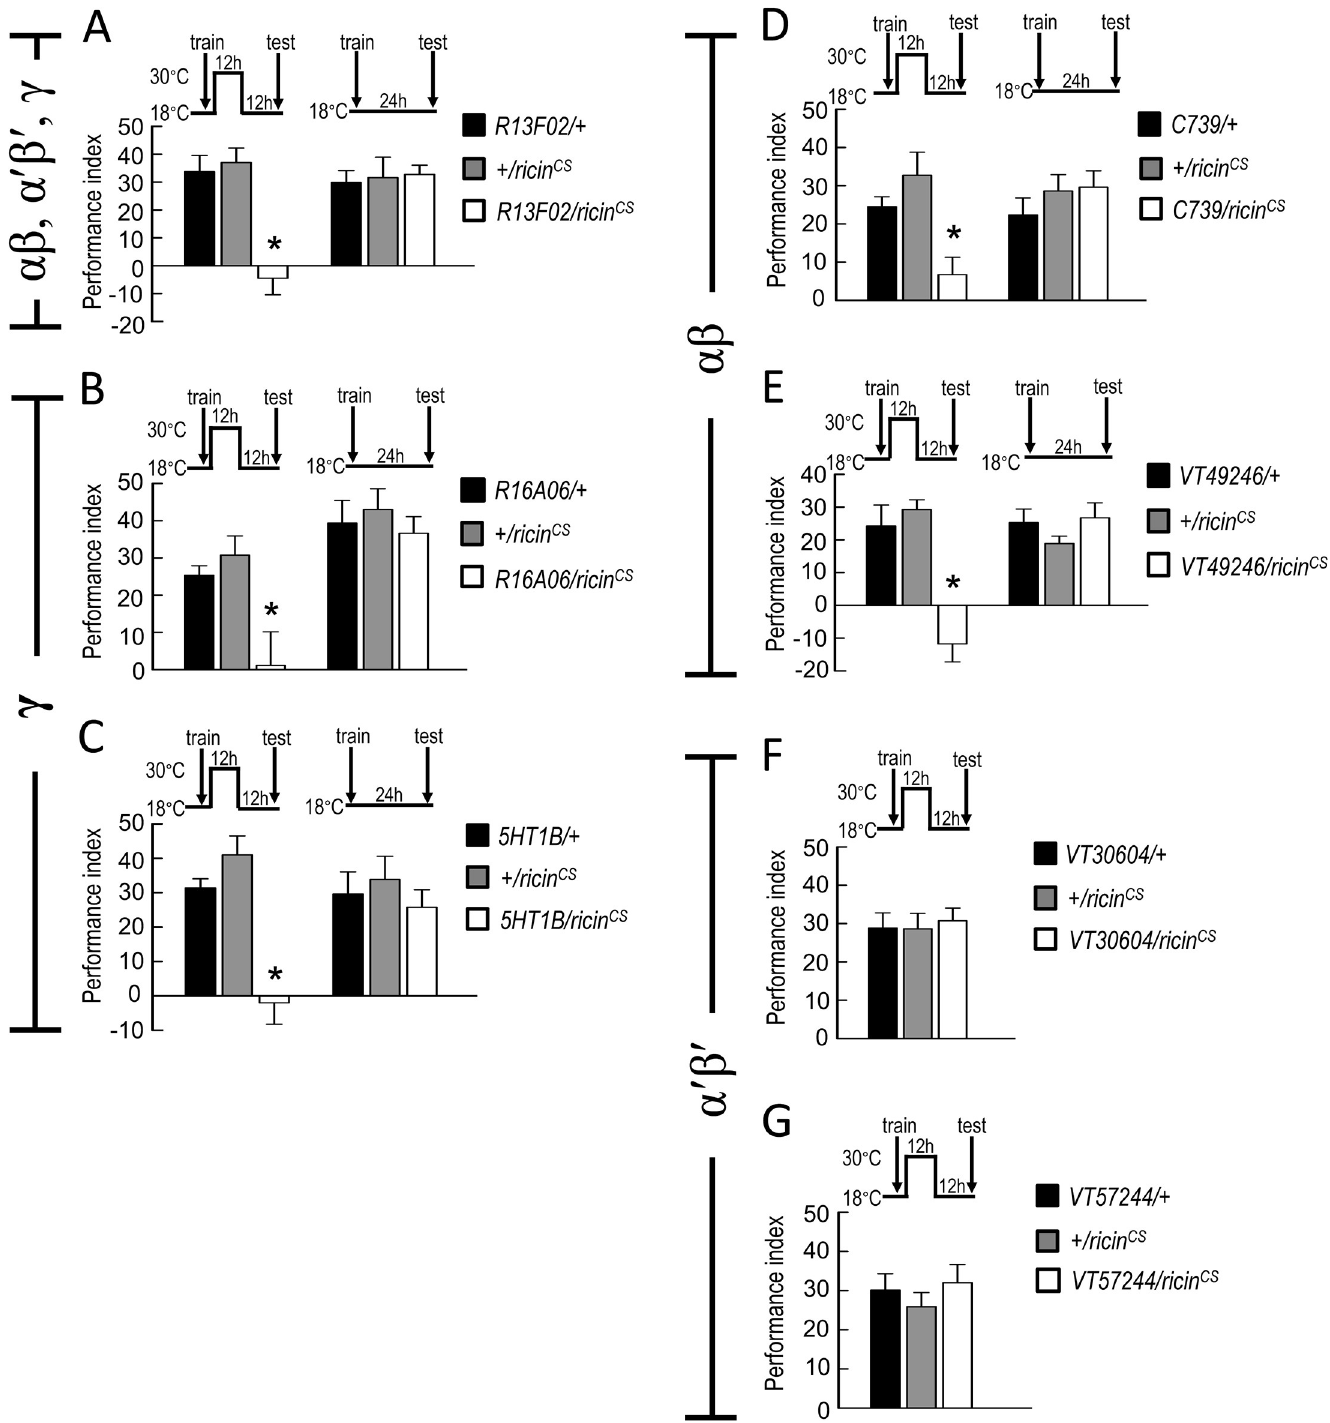
Fig 1. Blocking de novo protein synthesis in αβ and γ neurons during memory formation disrupts wLTM. (A) Blocking protein synthesis in MB neurons using R13F02-GAL4 to drive the expression of activated RICIN CS during memory formation impaired wLTM. After training at 18˚C, the flies were moved to 30˚C for 12 h to activate RICIN CS , moved back to 18˚C for another 12 h to inactivate RICIN CS , and then tested for memory retention at 18˚C (left panel). Each value represents mean ± SEM (N = 8). � , p < 0.05; one-way ANOVA followed by Tukey’s test. The 24-hour water-reward memory was normal with inactive RICIN CS (18˚C) expression in MB neurons all the way during behavioral assay (right panel). Each value represents mean ± SEM (N = 8). p > 0.05; one-way ANOVA. (B-C) Blocking protein synthesis during memory formation in γ neurons using R16A06-GAL4 (B) or 5HT1B-GAL4 (C) to drive the expression of activated RICIN CS (30˚C, left panel)